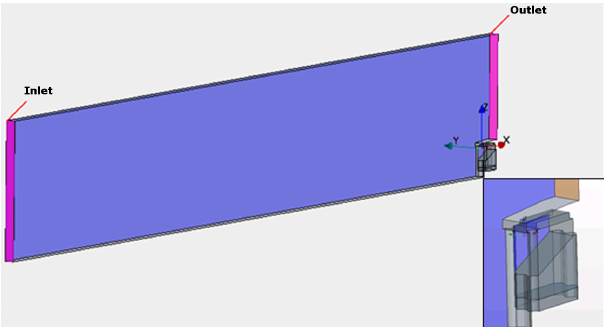
Figure 12. Domain, boundary conditions and structure details.